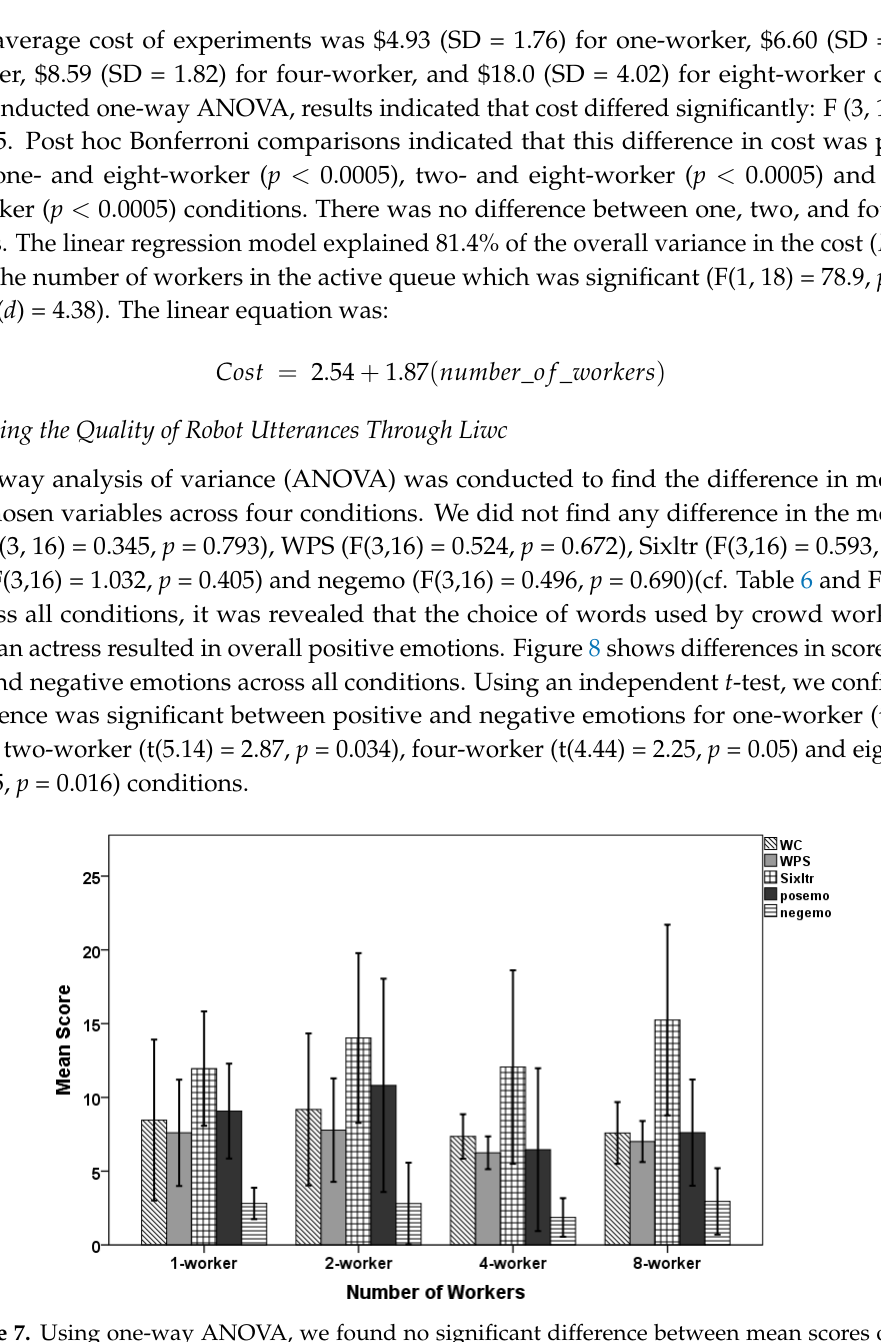
Figure 7. Using one-way ANOVA, we found no significant difference between mean scores of five categories across all